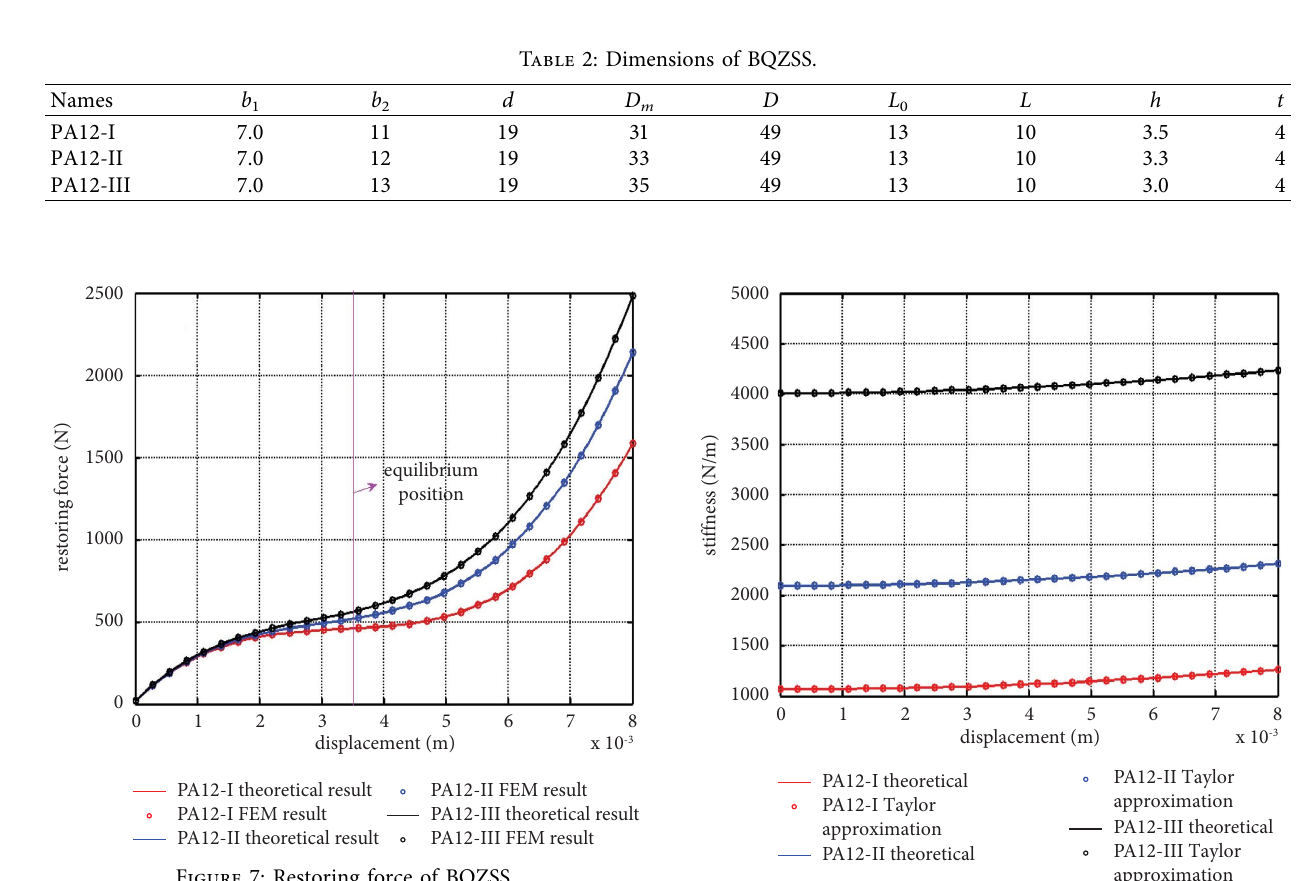
Figure 8: Stifness of